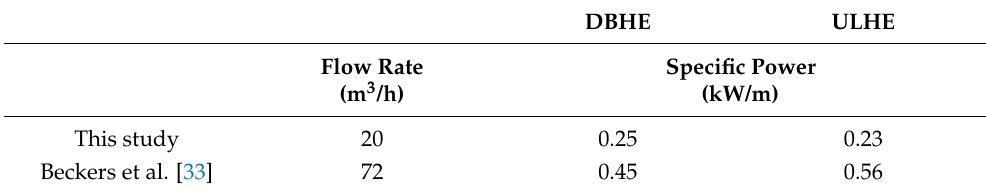
Table 6. Comparison of the specific power with data from Beckers et al.